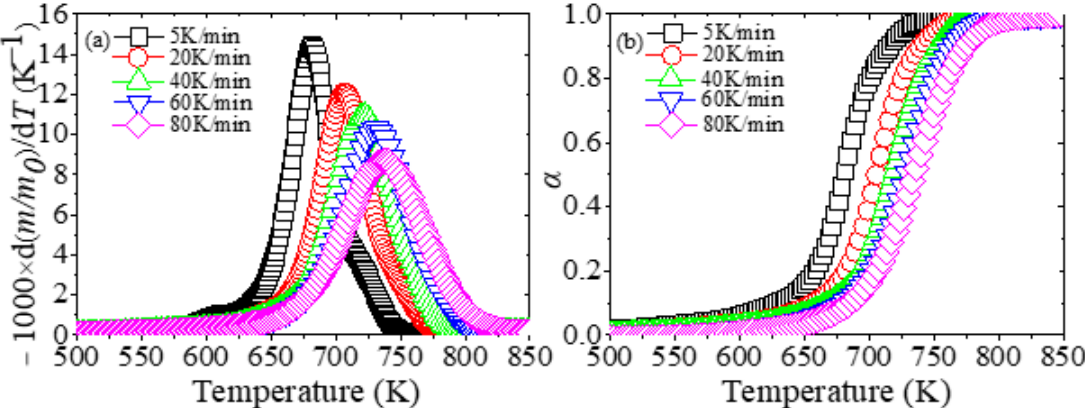
Figure 1. The ( a ) derivative mass loss (DTG) and ( b ) conversion rate profiles of degradation processes of extruded polystyrene (XPS) at different heating rates.